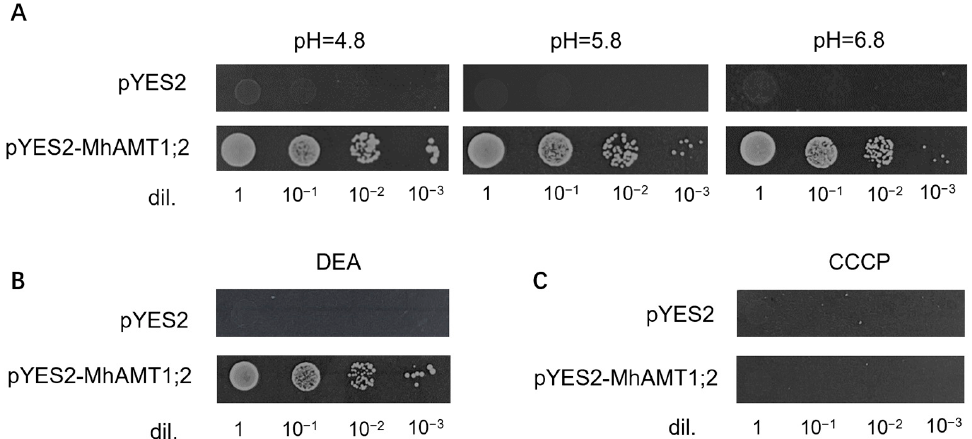
Figure 8. Proton and ATP dependence of NH 4+ uptake by MhAMT1;2. ( A ) Effects of external pH on the growth complementation of yeast cells. ( B ) Effects of protonophore DEA on the growth complementation of yeast cells. ( C ) Effects of CCCP on the growth complementation of yeast cells. The cells were growing on YNB plates containing 2 mM NH 4 Cl as N source. DEA (100 µ M) or CCCP (100 µ M) was added to the medium prior to the solidification of the plates.